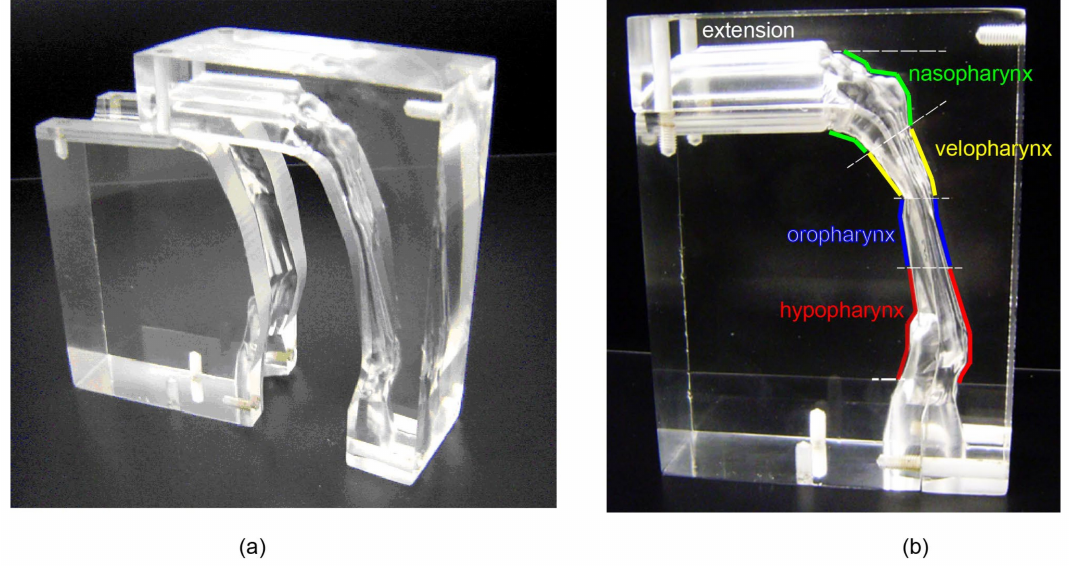
Figure 3. The cast replica of the human pharyngeal airway, ( a ) dismantled blocks ( b ) assembled model labelled with anatomical